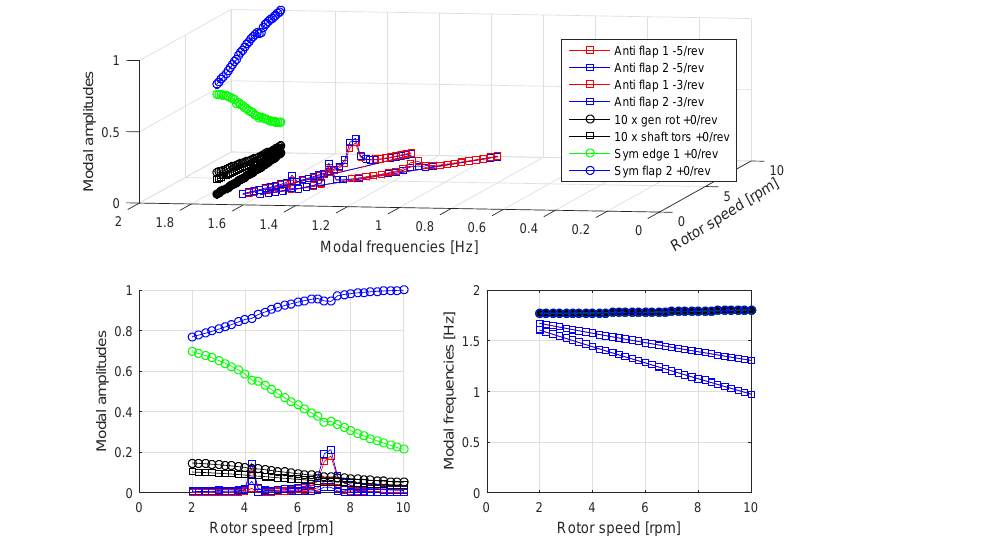
Figure 23. Harmonic modal components for the two-bladed turbine mode dominated by symmetric deflection of the rotor in the second flapwise DOF. Plot layout as in Fig.